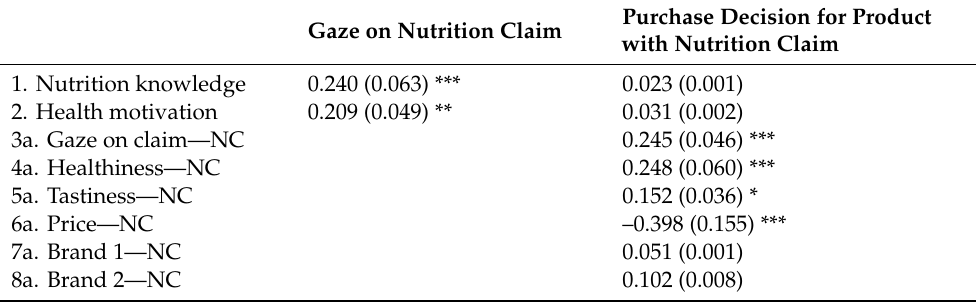
Table 7. Path coe ffi cients and their e ff ect sizes—nutrition claim.